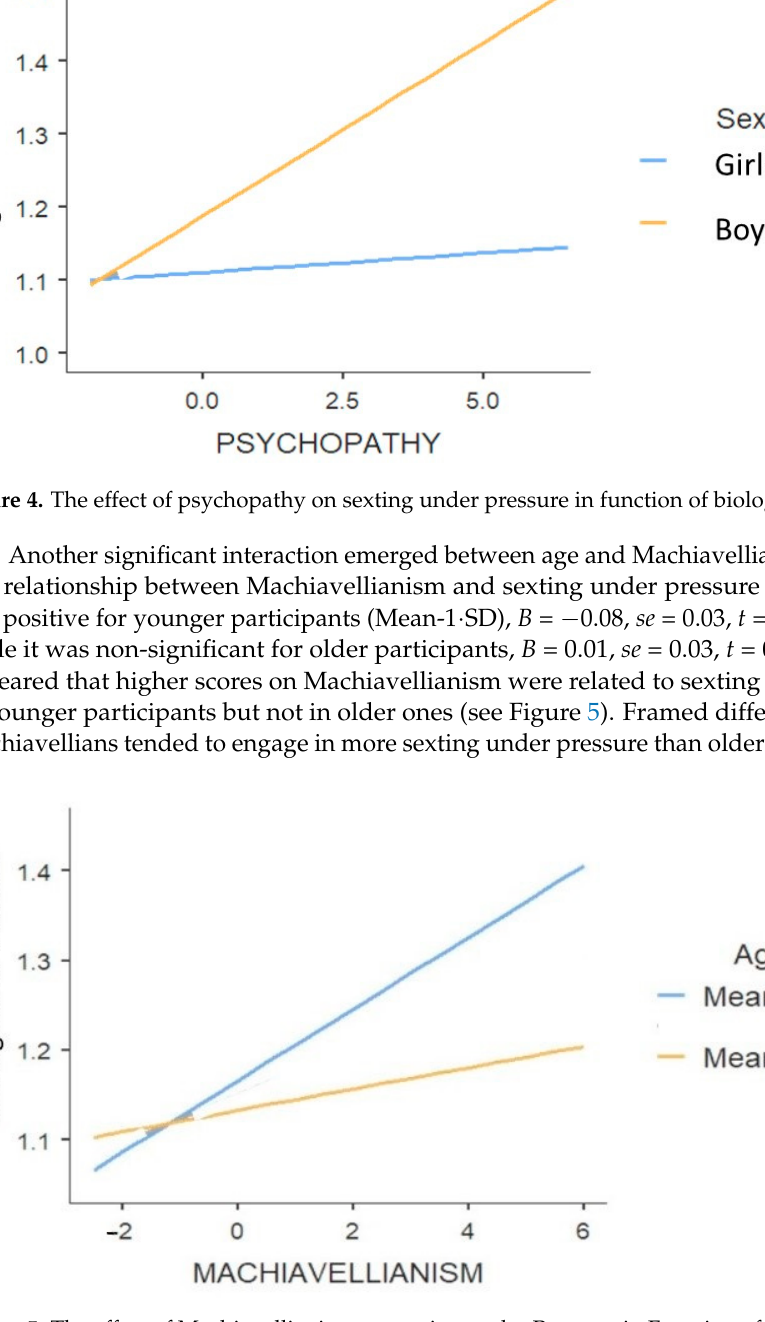
Figure 5. The effect of Machiavellianism on sexting under Pressure in Function of Age.